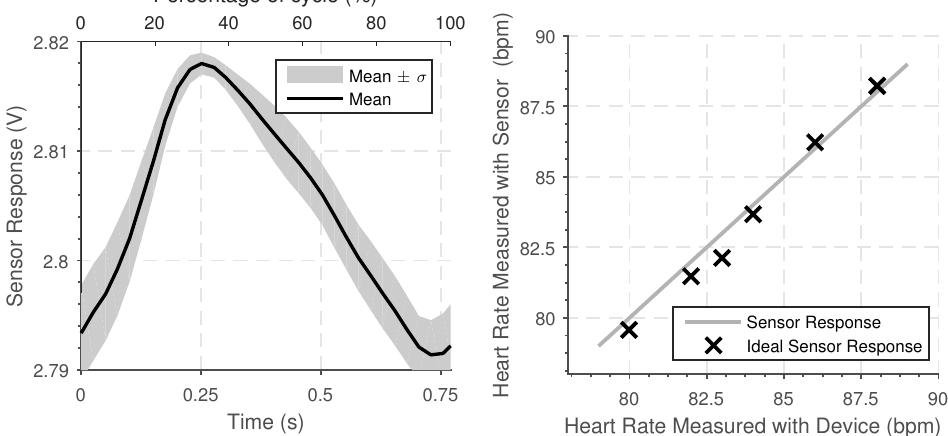
Figure 9. ( Left ) Average time series of the sensor response when the sensor is worn around the wrist for one period of heart beat when measured over a two-minute period. ( Right ) Experimentally measured heart rate measured over a thirty-second period and the heartrate determined by a commercial device (Polar M400, Polar Electro 2018,